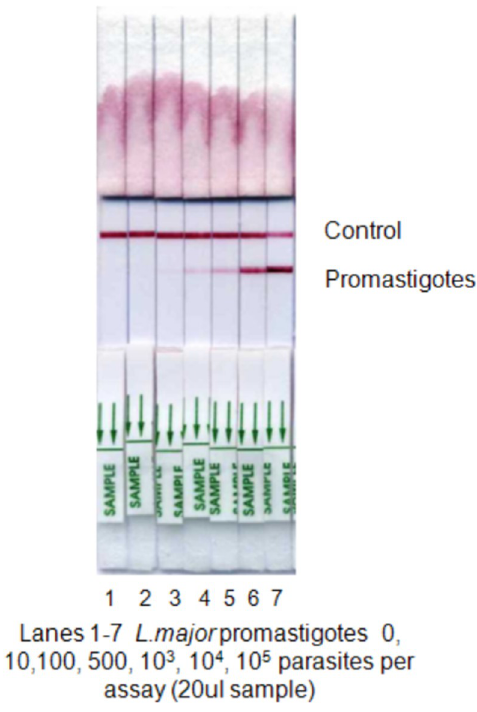
Fig 1. CL Detect Test Strip Intensity Compared to Number of Promastigotes. The intensity of the TSA Test Line increases with increasing parasite number. Lanes 1–7 show Leishmania major promastigotes from 0, 10, 100, 500, 10 3 , 10 4 , 10 5 parasites per assay (20 μ l